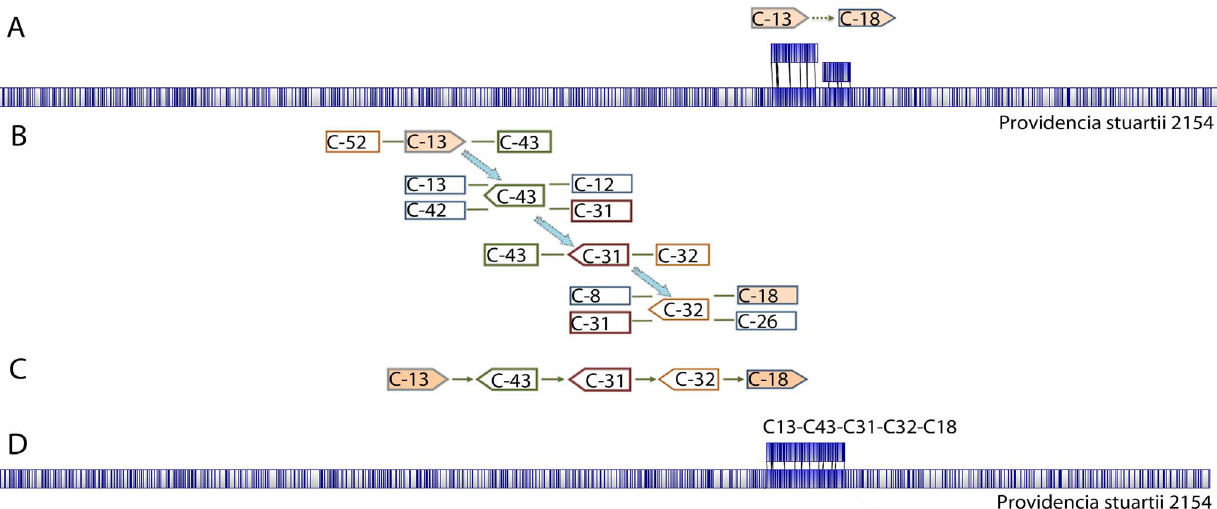
Figure 2. Integration of WGM alignment and 454 contig graph information for sequence assembly gap filling. The MapSolver alignment software was used with default parameters for in-silico alignment of sequence contigs to the WGRM. Unaligned regions are highlighted in white while alignment regions are shaded blue. Vertical lines represent NcoI cut sites. ( A ) Contigs 13 and 18 were in-silico digested and aligned to the WGRM to determine their orientations and the distance that separates them. There was a gap between contigs 13 and 18. ( B ) Contig branching information was used to fill the gap with contigs 43, 31, and 32. Contigs represented by boxes with right-pointing arrowheads are in the forward orientation relative to the WRGM; those represented by boxes with left-pointing arrowheads are in the reverse orientation; those represented by rectangular boxes are of unknown orientation relative to the WRGM. ( C ) Concatenation of contigs which were ordered and oriented by the WGM- enhanced gap-closure process. ( D ) Mapping the concatenated sequence to the WGRM to verify the quality of the gap filling. An in-silico digest of a contig is shown above the WGRM.